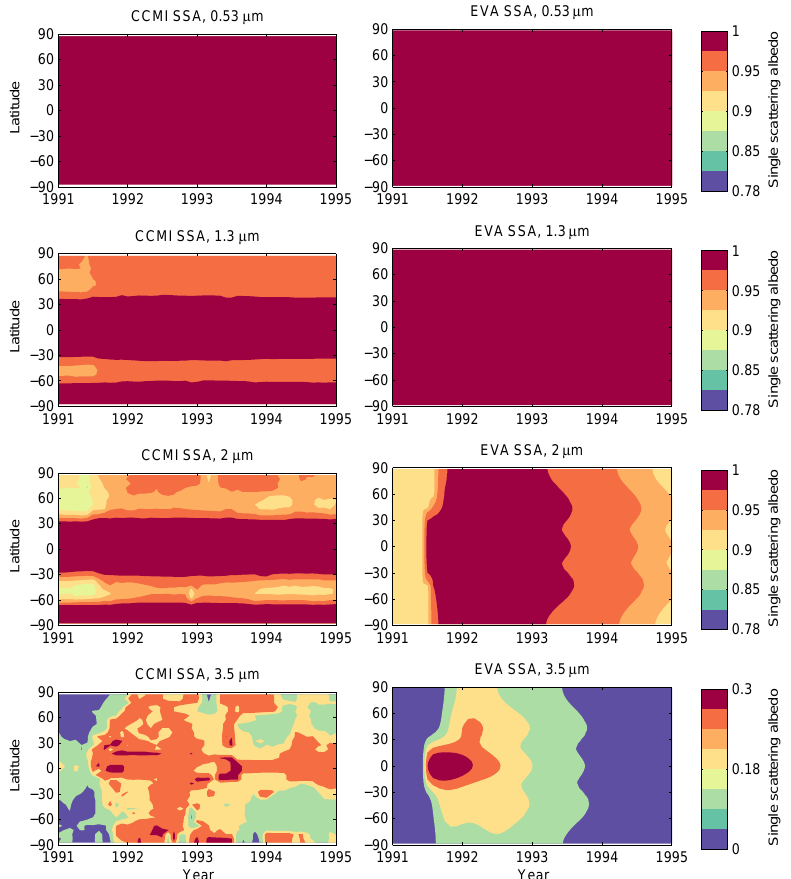
Figure 8. SSA after the Pinatubo eruption at 20km for selected wavelengths from (left) CCMI and (right) EVA. Note different color scale for the lowermost